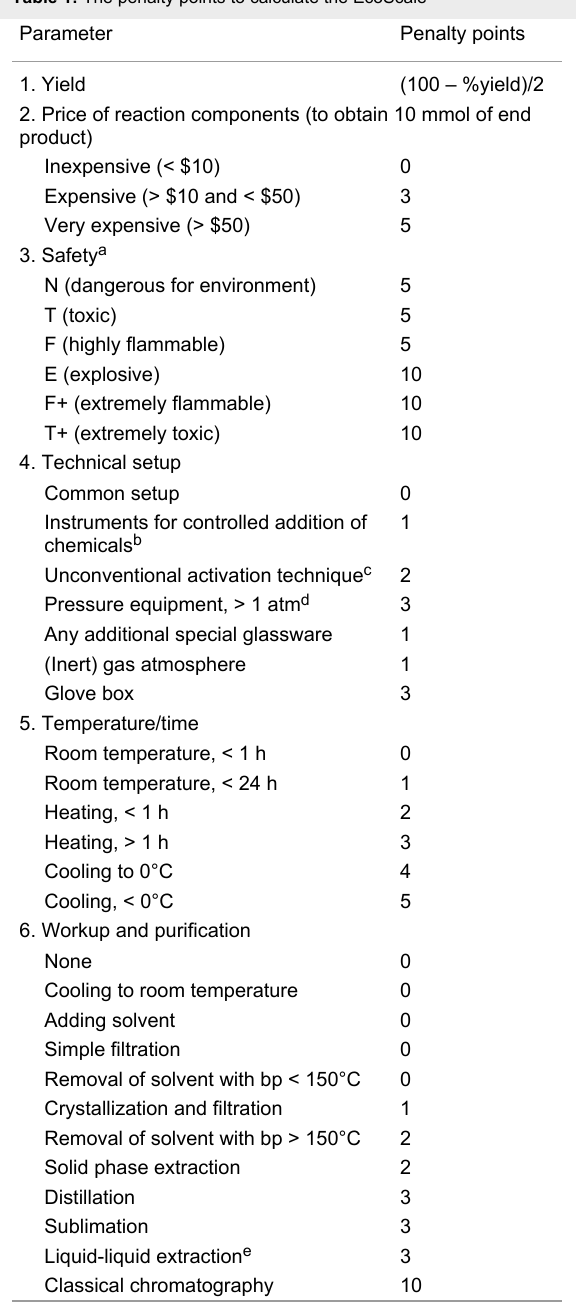
Table 1: The penalty points to calculate the EcoScale Parameter Penalty